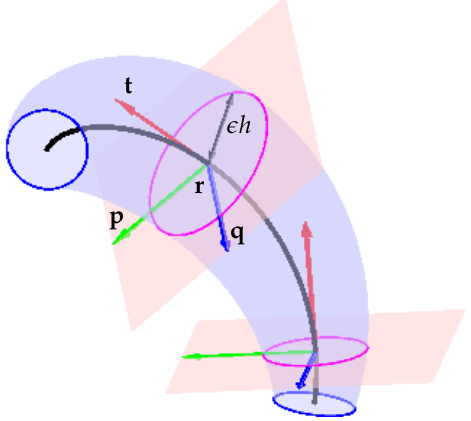
Figure 1. The physical domain. We consider a neighbourhood of a curve r (in black). The tangent vectors t (in red) are orthogonal to the normal planes (in pink). They intersect in this case the neighbourhood